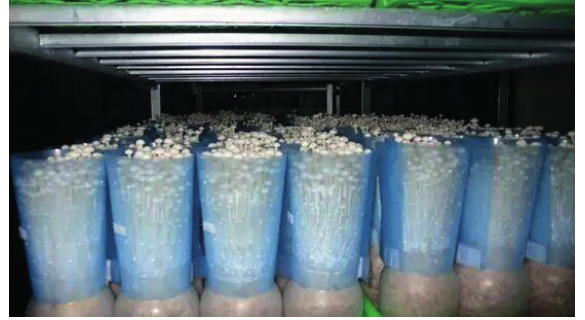
Fig. 1 Flammulina velutipes Figure 1: Flammulina velutipes